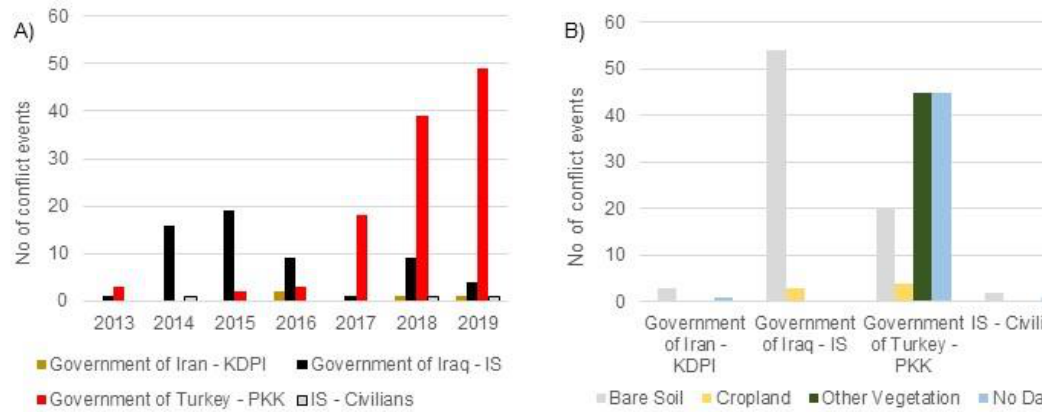
Figure 6. Conflict events recorded in the KR-I in the UCDP dataset between 2013 and 2019, divided by ( A ) the parties in conflict and year, and ( B ) the parties in conflict and corresponding LULC class.